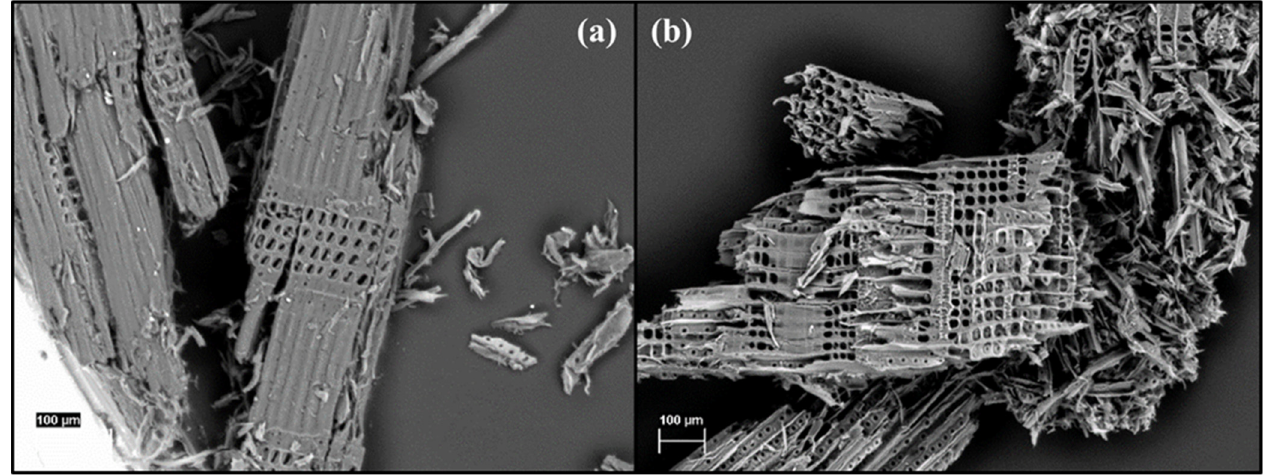
Figure 3. Scanning electron micrographs of pine wood biomass before ( a ) and after ( b ) [N11H(2OH)][LAC] pretreatment [pretreatment conditions: 180 ℃ , 3 h, 1:3 (BM:PIL